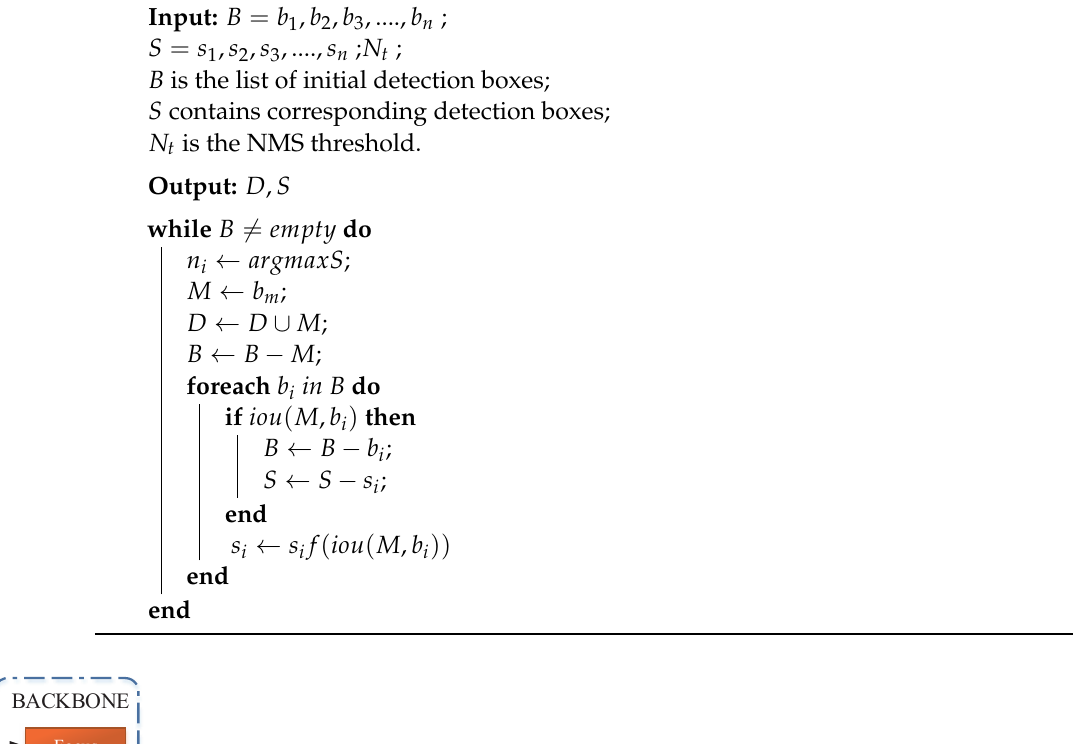
Algorithm 1: Soft non-maximum suppression.